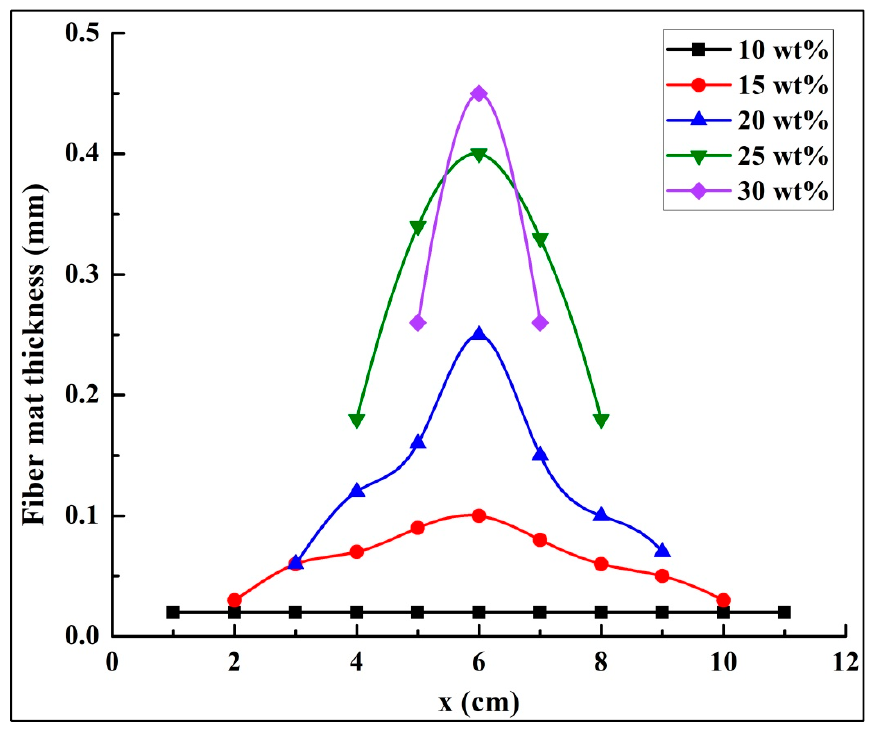
Figure 9. Fiber mat thicknesses at central line, collected for five different solution concentrations. The collecting time was set at 120 min. The processing parameters were as follows: Applied voltage of 20 kV, working distance of 20 cm, and flow rate of 1.0 mL/h.